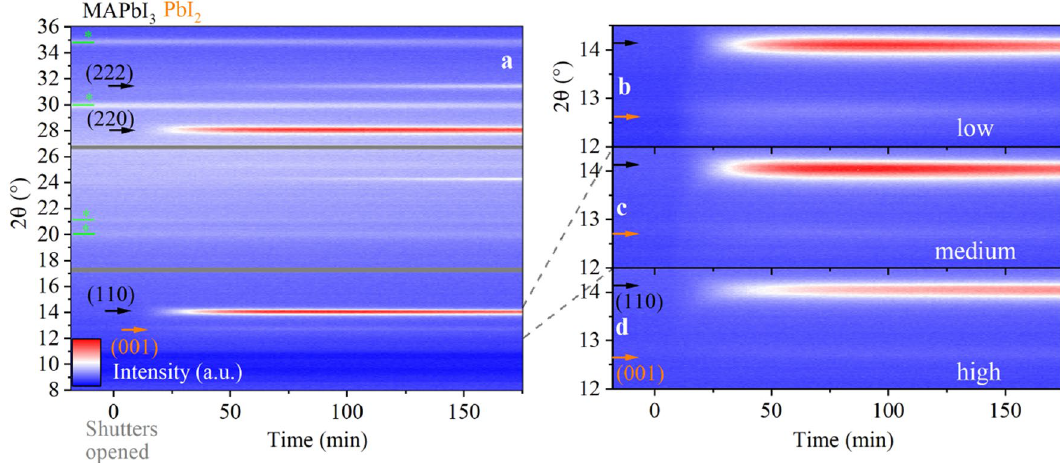
− 5 − 5 mbar, a,c ), low (4 × 10